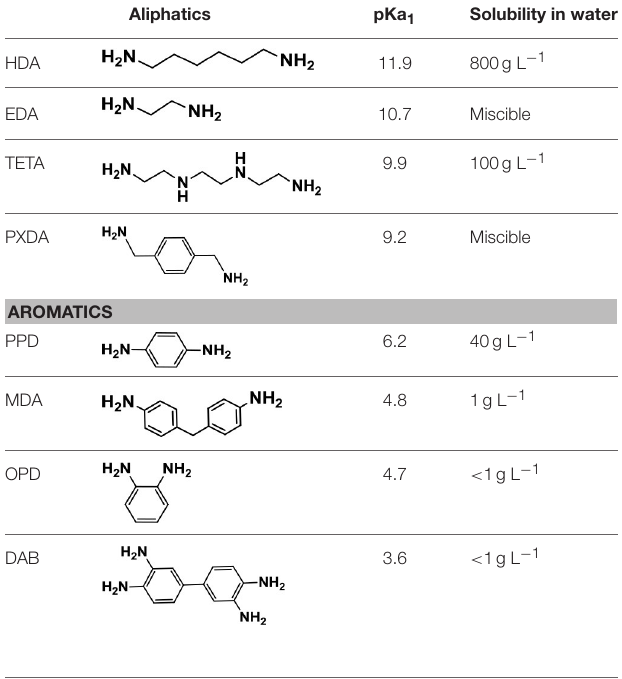
TABLE 2 | Bulk resistance (R), resistivity ( ρ ), dimensions, and density (d) of the rGO aerogels. rGO Mass (mg)